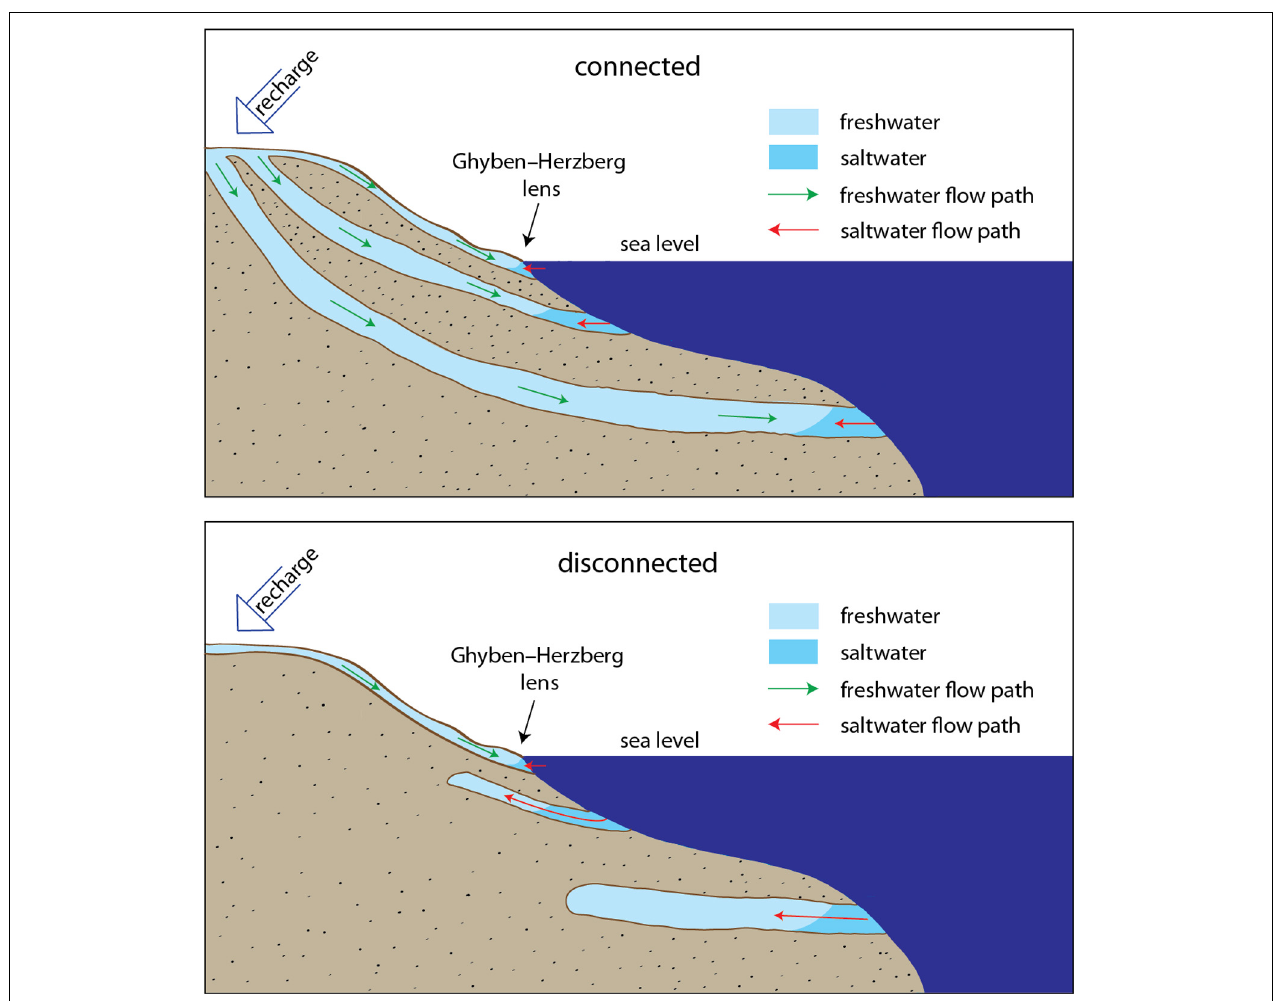
FIGURE 1 | Cartoon depicting the differences between offshore freshened groundwater (connected) and paleo-groundwater (disconnected) systems. Modern day “active” aquifers are recharged by precipitation (green arrows). Fossil aquifers are no longer fed by meteoric water, however, both systems are subject to saltwater intrusion becoming saline over time (red